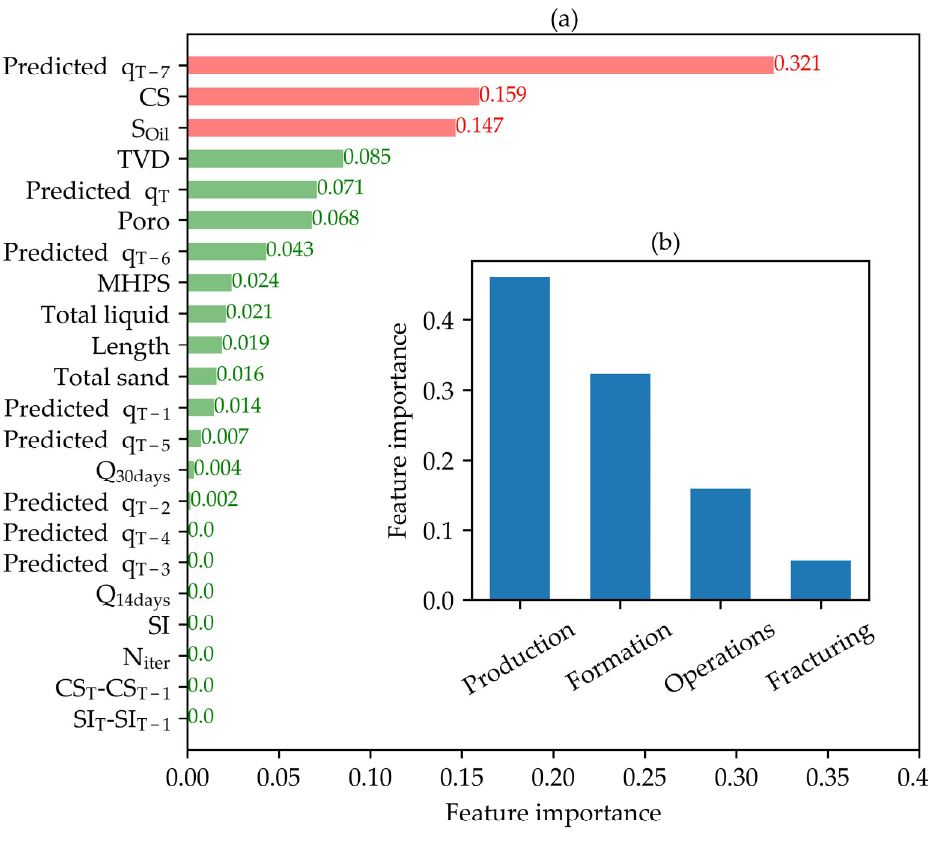
Figure 19. Feature importance ranking of RF: ( a ) sorted by single parameter; ( b ) sorted by parameter types.